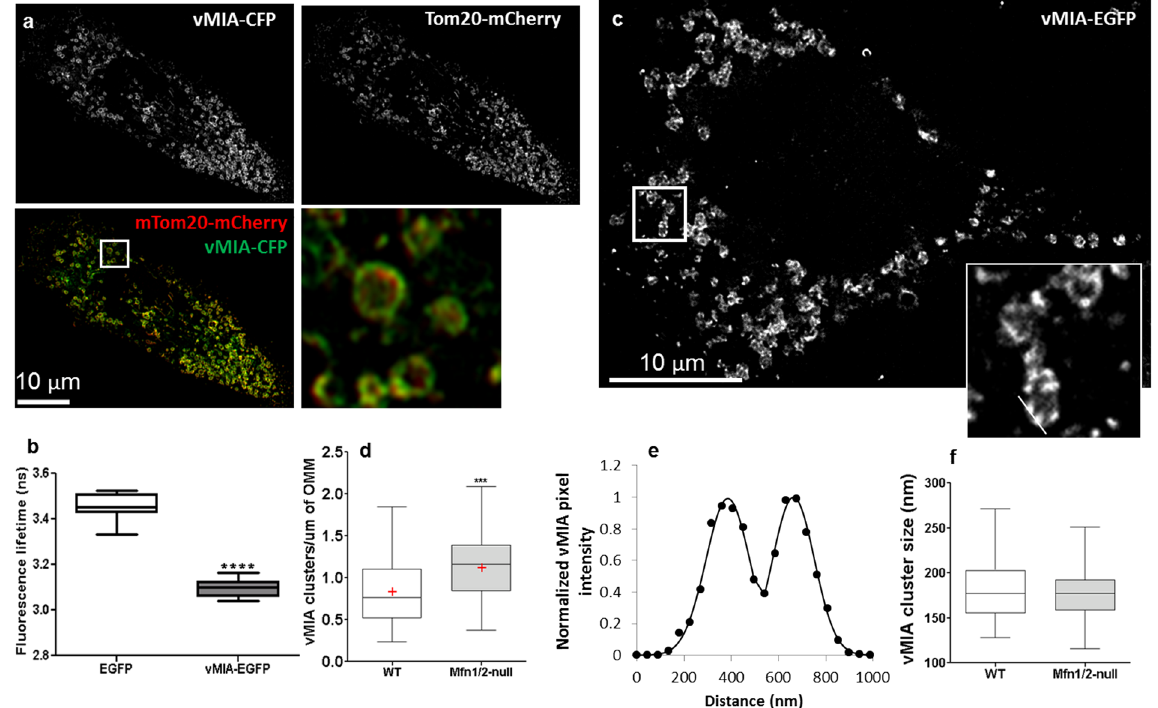
Figure 4. Role of mitofusins (Mfn1/2) on vMIA trafficking and clustering on mitochondria. ( a ) Mfn1/2-null MEFs were transiently transfected to express vMIA-CFP (pseudocolored green) and Tom20-mCherry (red) and imaged by confocal microscopy. The images show a single confocal plane from a deconvolved z-stack presented as monochrome images of the individual channels, which are pseudocolored for the merged image, and the boxed region marks the region zoomed in the inset. ( b ) The fluorescence lifetime comparison of cytosolic EGFP ( τ = 3.46 ± 0.015 ns, n = 150 regions from 15 cells) and vMIA-EGFP ( τ = 3.10 ± 0.011 ns, n = 130 regions from 13 cells) in Mfn1/2-null MEFs. ( c ) A single plane from an MSIM z-stack images showing clustered distribution of vMIA-EGFP on the OMM of an Mfn1/2-null MEF. A zoom of mitochondria shows vMIA clustering. ( d ) The number of vMIA clusters/ µ m of the OMM in WT MEFs (n = 50) and Mfn1/2-null MEFs (n = 40) are shown. ( e ) Normalized intensity profile along the solid line shown in the zoomed inset in panel c. ( f ) The FWHM of vMIA clusters (n = 40) in Mfn1/2-null MEFs were measured and plotted. The line and red cross mark indicate the median and mean, respectively. **** Represents p <